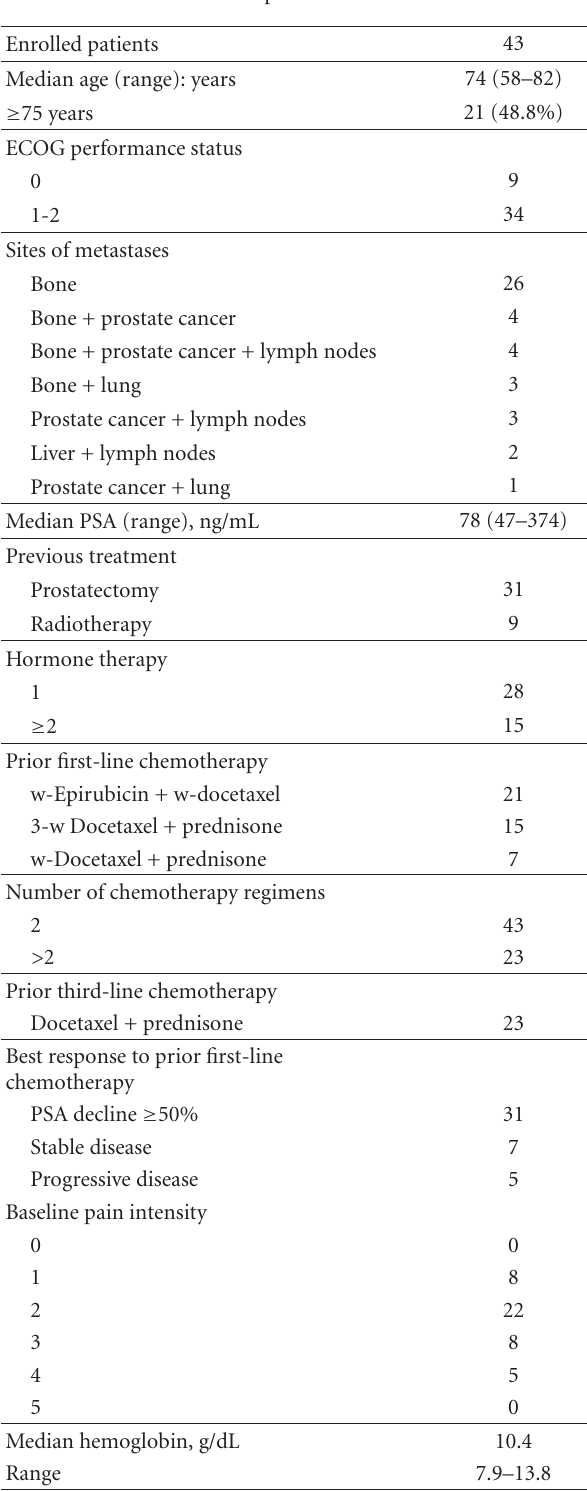
Table 2: Main patient